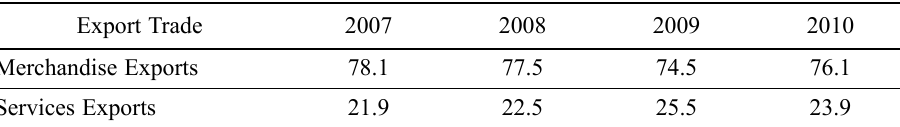
Table 2. Singapore’s export components (% share of total exports),